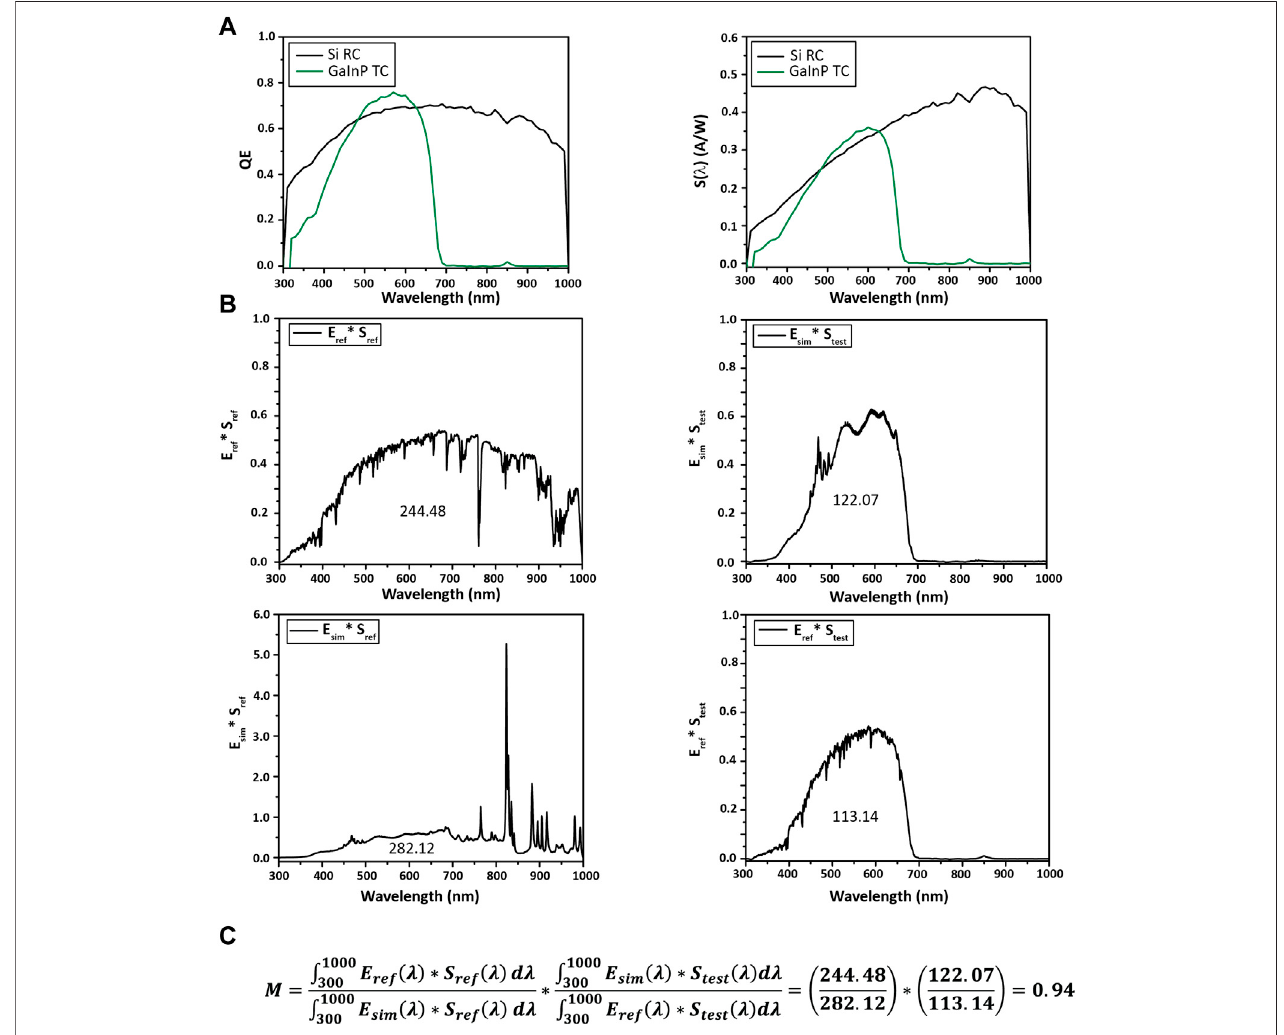
FIGURE9 | CalculatingM for aSi reference cell(RC) and a GaInP test cell (TC). (A) Quantum ef fi ciency and spectral response S( λ )from 300to1,000 nm. (B) Each productplottedagainst wavelengthforcalculatingM,withtheintegralnotedunderthecurve. (C) Miscalculatedtobe0.94forthissystem,indicatingthetest cellshould be moved closer to the solar simulator (vide infra). Speci fi cally, the mismatch factor can be calculated with Eq. 4 .